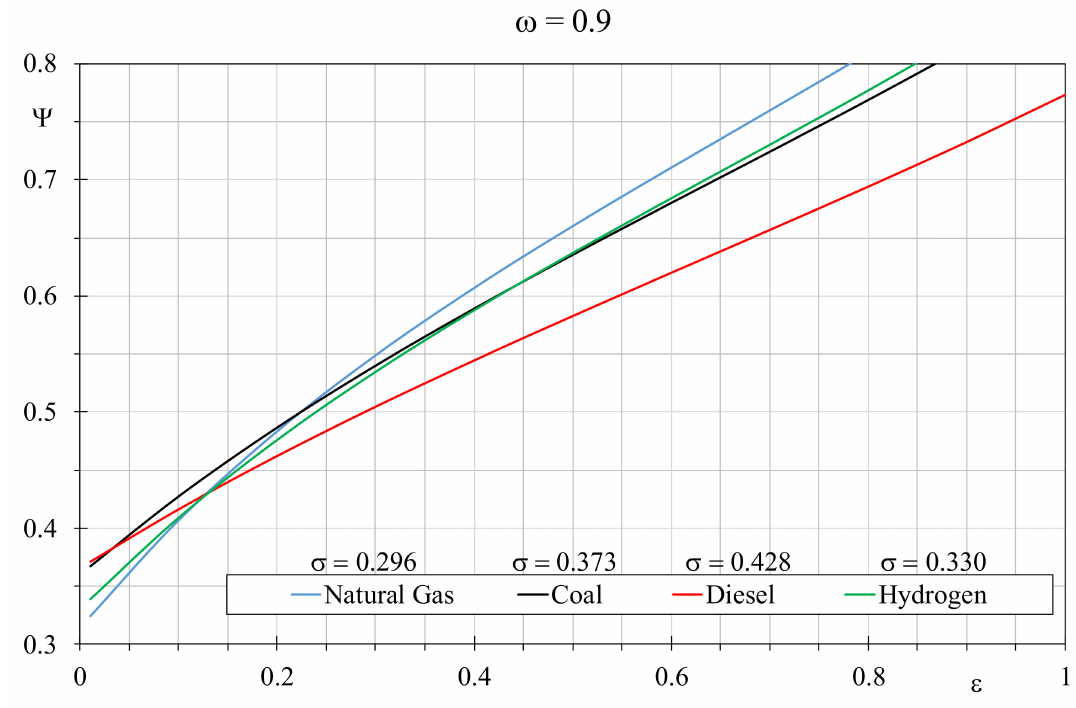
Figure 6. Comparison of the EQI related to the boiler heat exchanger efficiency for the considered fuels, with different values of the dimensionless temperature factor and setting ω =